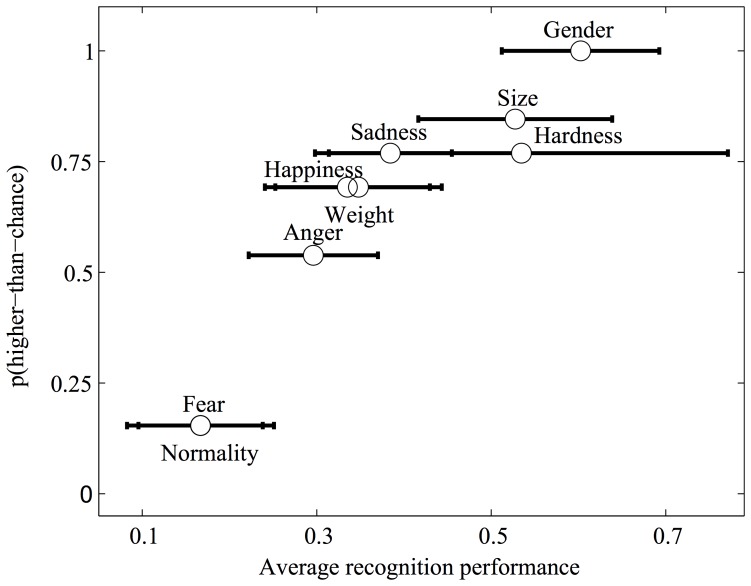
Analysis of the performance in the recognition of the investigated properties of the walking event.Performance scores of 1, 0 and -1 correspond to perfect recognition, chance recognition and perfect mis-recognition, respectively. The abscissa shows, for each of the properties of the walking event, performance scores averaged across all the listeners (Spearman rank correlation coefficients). The ordinate shows the proportion of listeners with higher–than–chance recognition performance for each of the estimated walkers' properties. Error-bars  = 95% confidence intervals for the average performance. Gender  =  “maleness”.